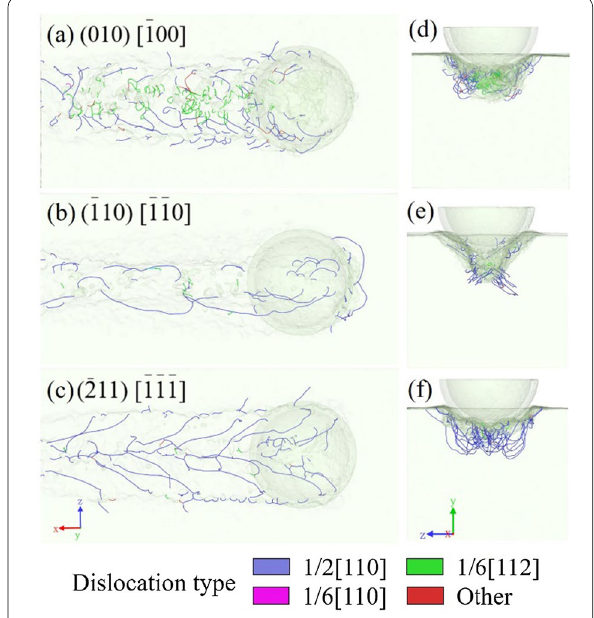
Fig. 12 Perspective views of the dislocation distribution in the